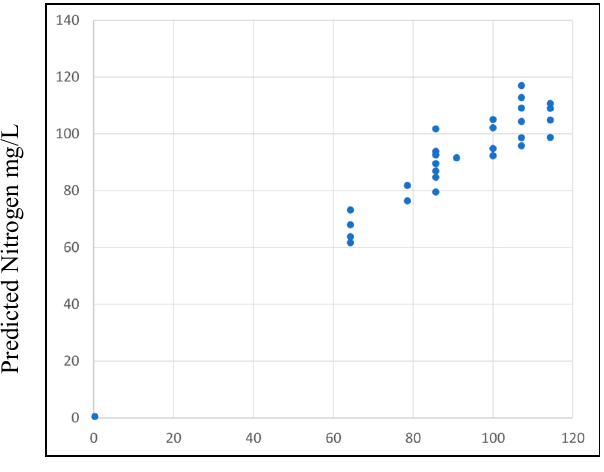
Figure 12. Tank S actual nitrogen plotted against the predicted nitrogen using the MLR model.